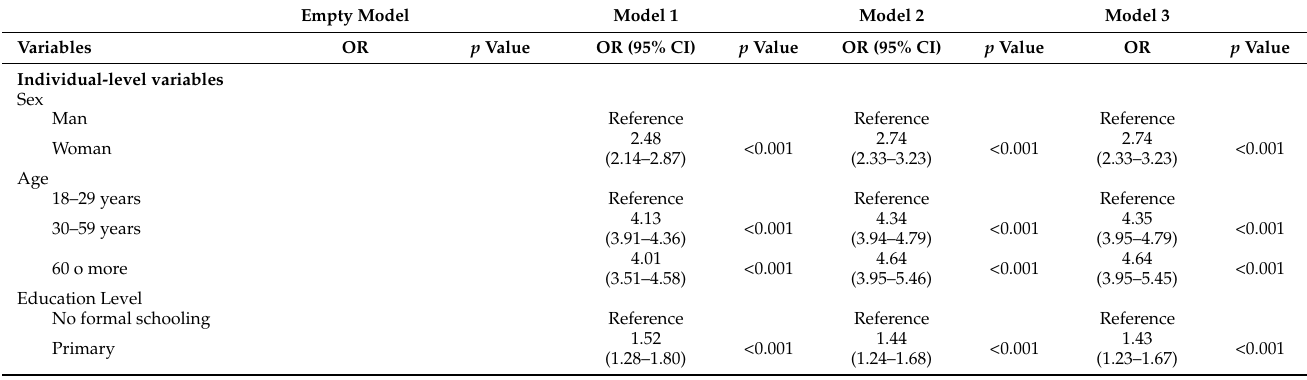
Table 2. Multilevel modeling